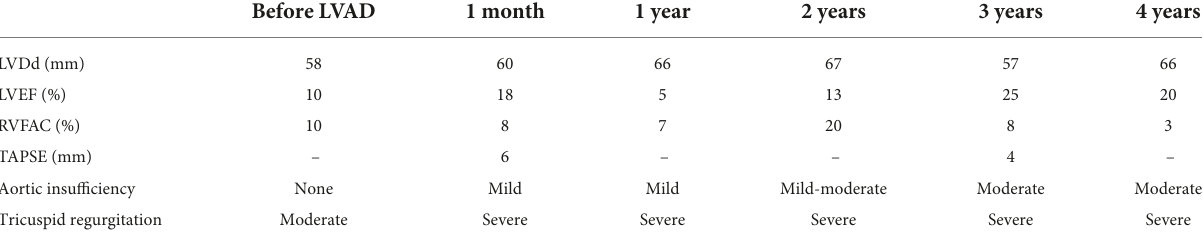
TABLE 5 Trend of echocardiographic data in Case 2.